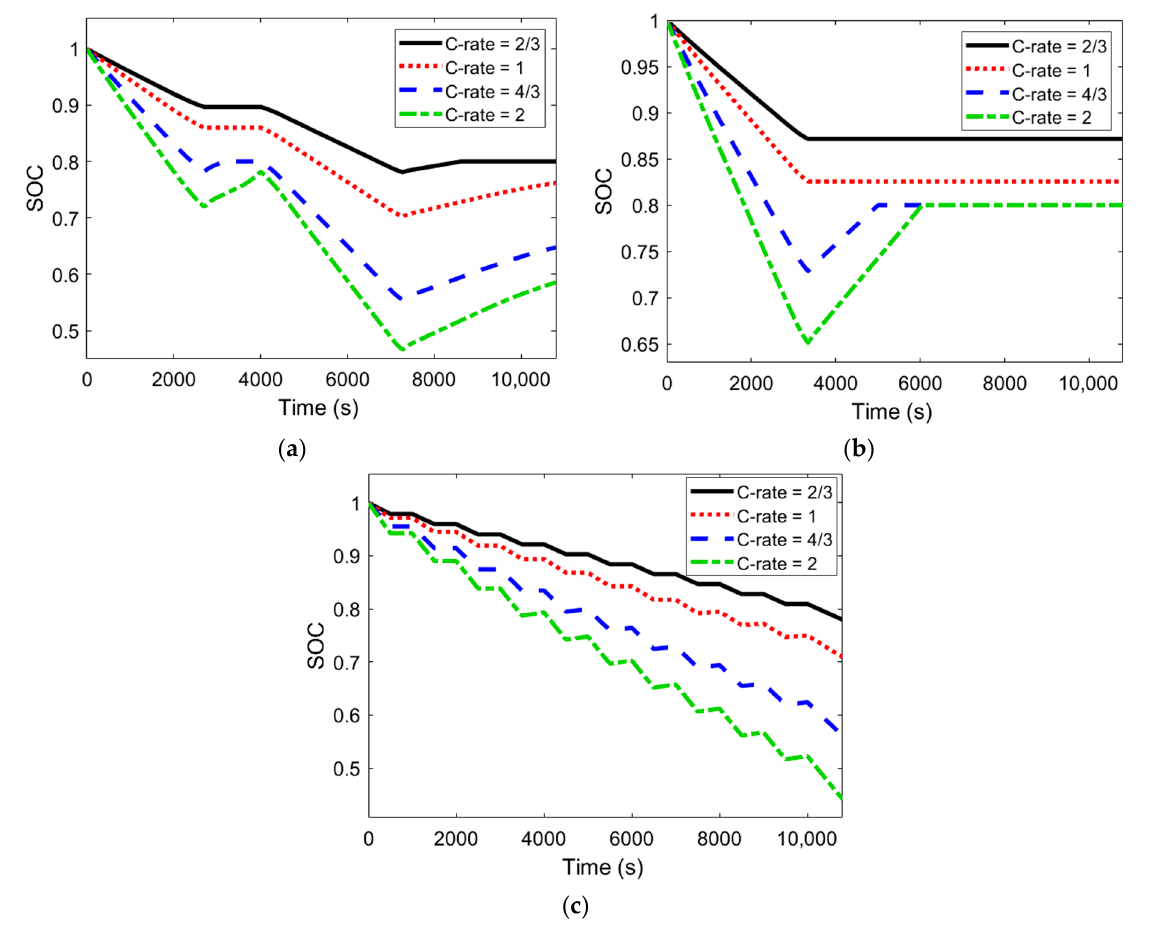
Figure 8. The impact of changes in the C-rate of the batteries on the output SOC: ( a ) case 1, ( b ) case 2, and ( c ) case 3.